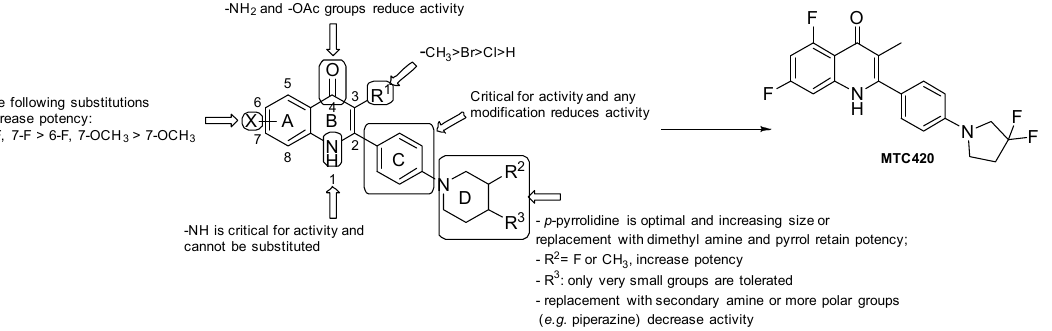
Figure 3. SARs of Quinoline/quinolone derivatives and the chemical structure of MTC420.